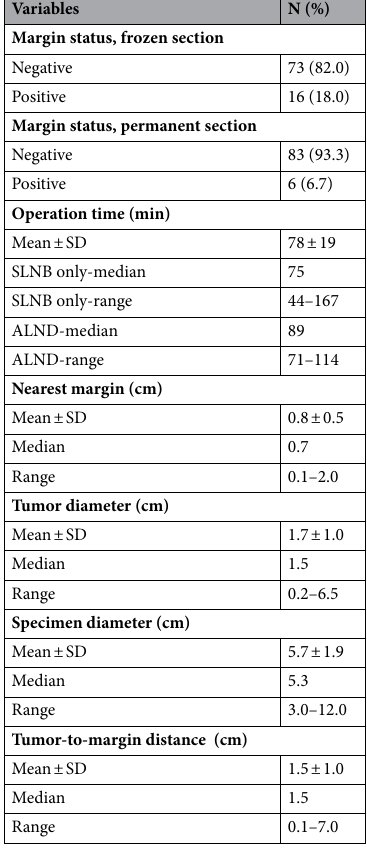
Table 2. Characteristics of the surgical specimens. SD standard